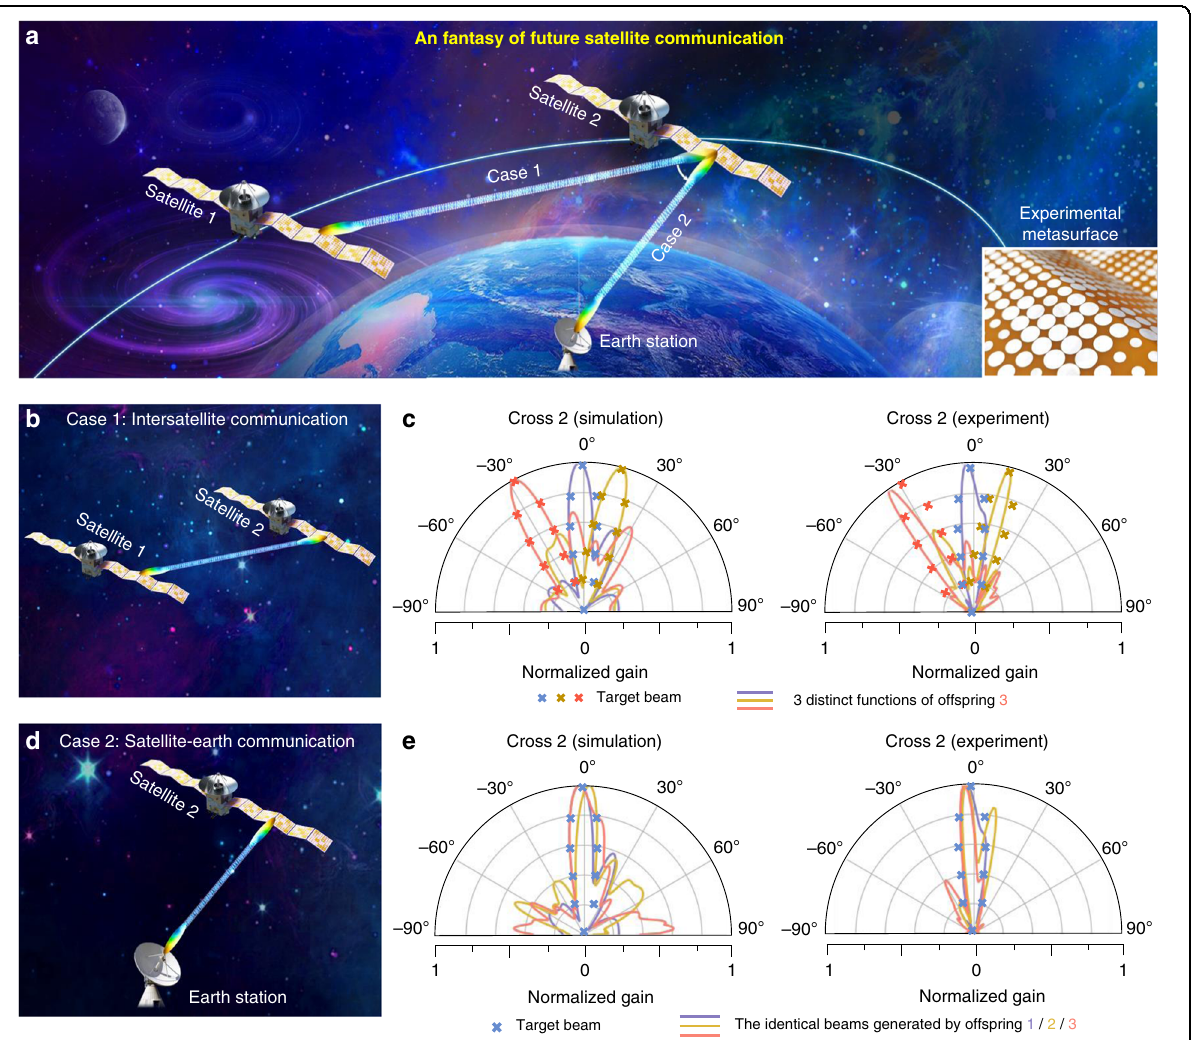
Fig. 5 A fantasy of future satellite communication and experiments for origami metasurfaces. a Schematic of satellite communication based on intelligent origami metasurfaces. As a fl exible, ultrathin, and low-cost competitor for free beam forming, the origami metasurfaces can be con fi rmed on the wings of satellites, which can be freely folded and stretched. Two satellites and one earth station are depicted to illustrate b intersatellite communication (case 1) and d satellite-earth communication (case 2). c Simulation and experimental results for case 1. For example, for offspring 3 in Fig. 4a, we show that distinct functions can be easily achieved by our knowledge-inherited paradigm. Conducted as the main section, only cross 2 is presented. e Simulation and experimental results for case 2. Considering that the satellites and receivers on Earth are relatively static, satellites with an offspring of 1/2/3 are able to generate identical